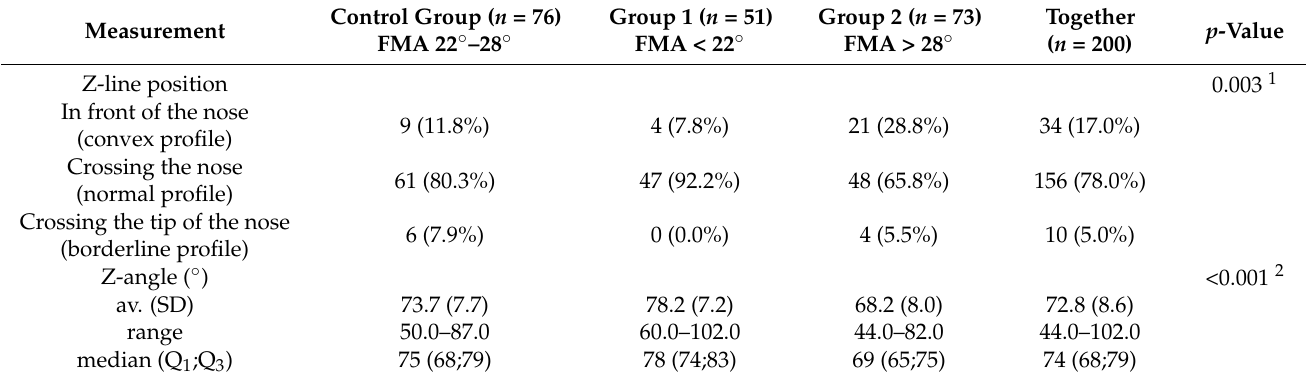
Table 5. Distribution of the Z-line position and the values of the Z-angle among the examined groups.